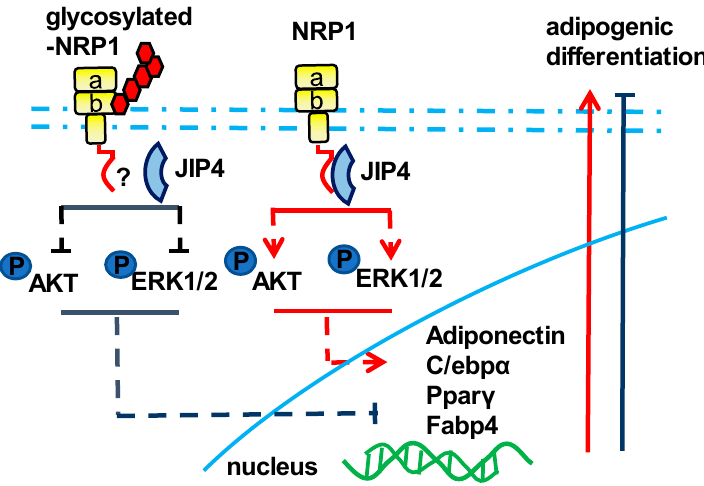
Figure 6. Schematic of the NRP1–JIP4–Akt/ERK signaling pathway promoting adipogenic differentiation of C3H10T1/2 cells.